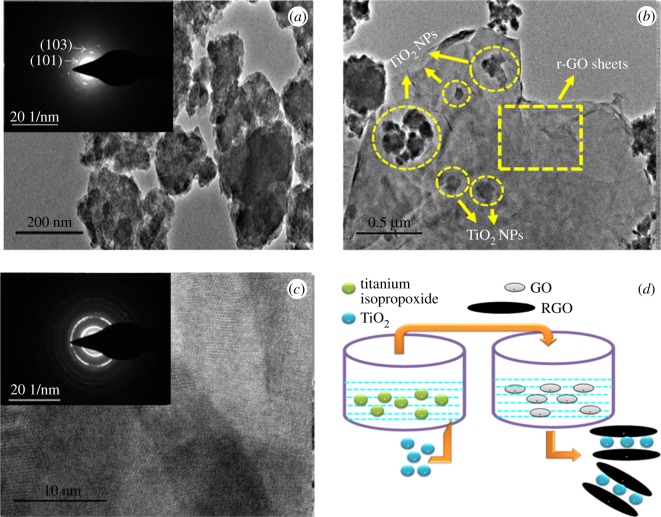
(a) TEM image and SAED pattern of TiO2 nanoparticle, (b) TEM image of TiO2: Sr/r-GO. (c) HR-TEM and SAED image of graphene. (d) Synthesis mechanisms of TiO2:Sr/r-GO.